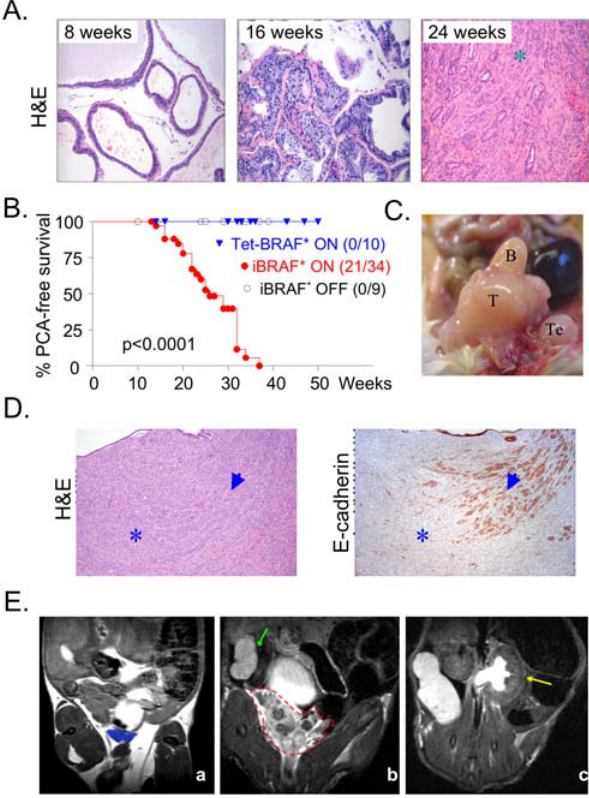
Figure 2. iBRAF* transgenic males develop invasive adenocar- cinoma of the prostate. A. Time-course histological analysis of prostate samples from iBRAF* transgenic mice (on doxycycline) at the indicated ages. Hyperplastic lesions were detected in a 16-week-old iBRAF* transgenic mouse on doxycycline. Up to an age of 24 weeks, approximately 50% of iBRAF* transgenic mice developed PCA. B. Kaplan-Meier analysis of PCA-free survival in iBRAF* (on doxycycline, n=34), iBRAF* (off doxycycline, n=9), and Tet-BRAF* (on doxycycline, n=10) transgenic males. Only double transgenic iBRAF* mice given doxycycline in their drinking water developed PCA with an average latency of 24 weeks (standard deviation= 6 6 weeks). C. Gross morphology of a prostate tumor from an iBRAF* transgenic mouse. T indicates tumor; B, bladder; and Te, testis. D. The transition from ductal (arrowhead) to spindle (asterisk) morphology is coincident with loss of E-cadherin expression in iBRAF* PCA, consistent with EMT (epithelial- mesenchymal transition). E. Detection of PCA in live mice by MRI. Panel a is a representative image of a WT mouse with normal prostate (highlighted in blue). Panel b is a representative MR image of PCA in an iBRAF* male on doxycycline (red outline; note heterogeneous signals within the lesion). Panel c is a representative MR image of hydronephrosis detected in an iBRAF* mouse with PCA. Note enlarged distended kidney (yellow arrow) in contrast to normal kidney in panel b (green arrow), indicating accumulation of urine in the kidney due to outflow obstruction by the tumor.